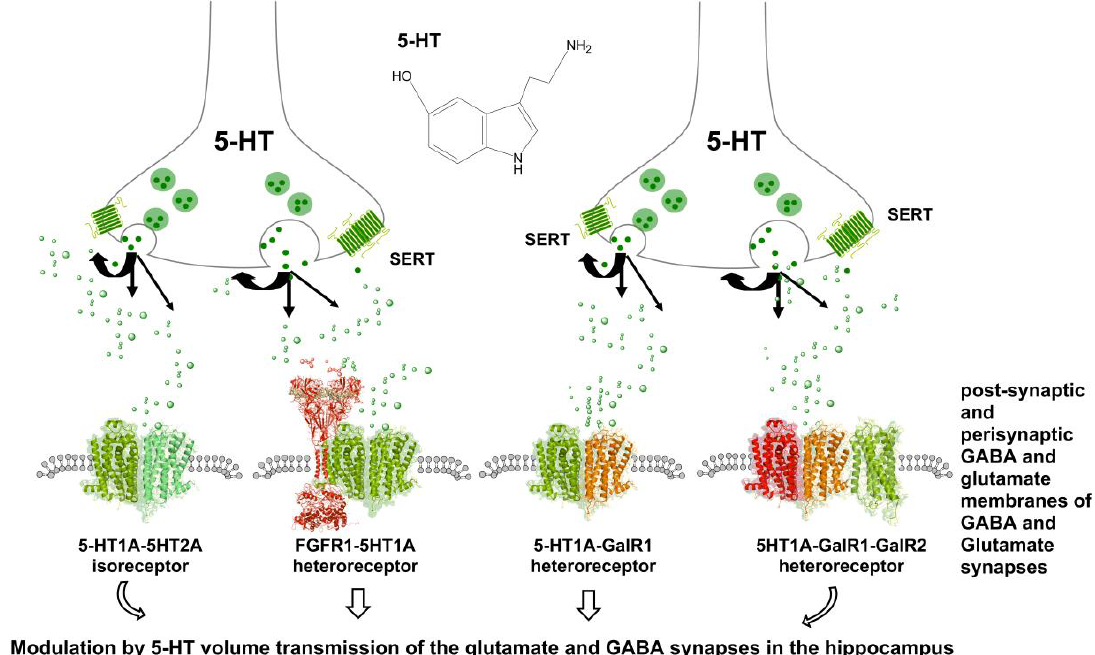
Figure 1. Illustration of how serotonin volume transmission can reach the 5-HT1A–FGFR1, 5-HT1A–5-HT2A, GalR1–5-HT1A, and GalR1–GalR2–5-HT1A heteroreceptor complexes. The